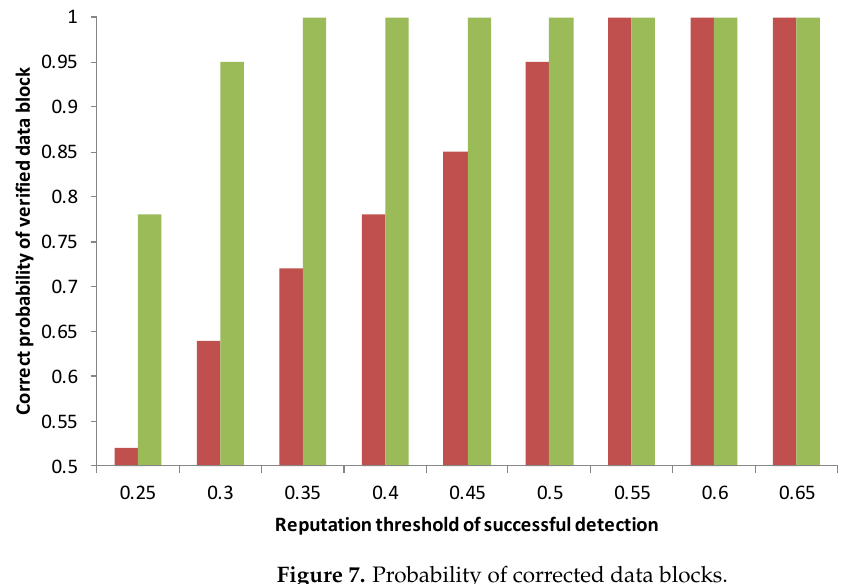
Figure 7. Probability of corrected data blocks.